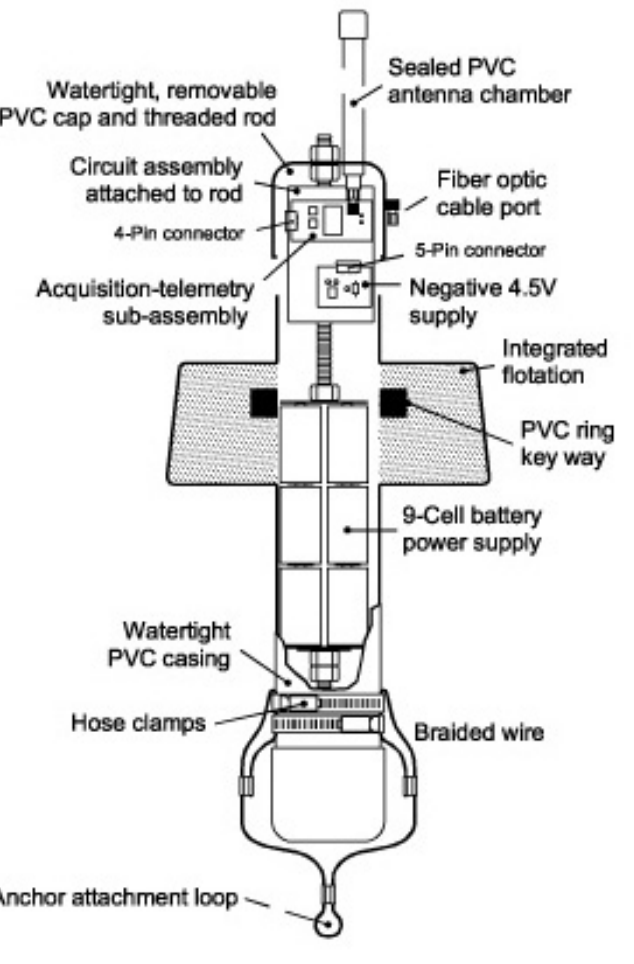
Figure 5. Cutaway drawing of a data buoy showing arrangement of major